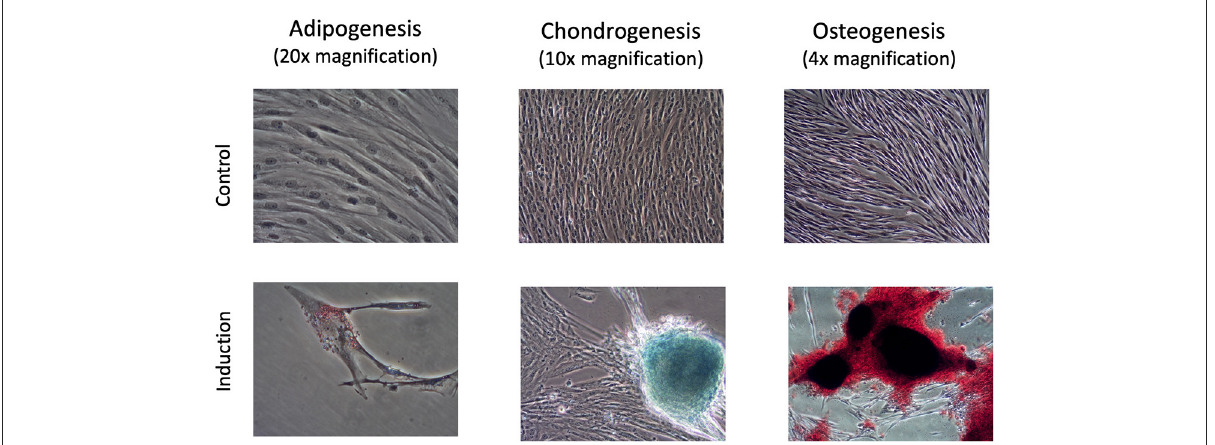
FIGURE2 Responses of UMSCs when exposed to induction medium for adipogenesis, chondrogenesis, and osteogenesis, compared with the control condition of culture medium alone. The staining pattern in the adipogenic differentiation induction medium results in small, red-staining intracellular vacuoles. The characteristic blue-staining nodules of chondrogenic cell differentiation are evident, as is the presence of extensive, red-stained extracellular matrix associated with cells that have differentiated along the osteogenic cell lineage.